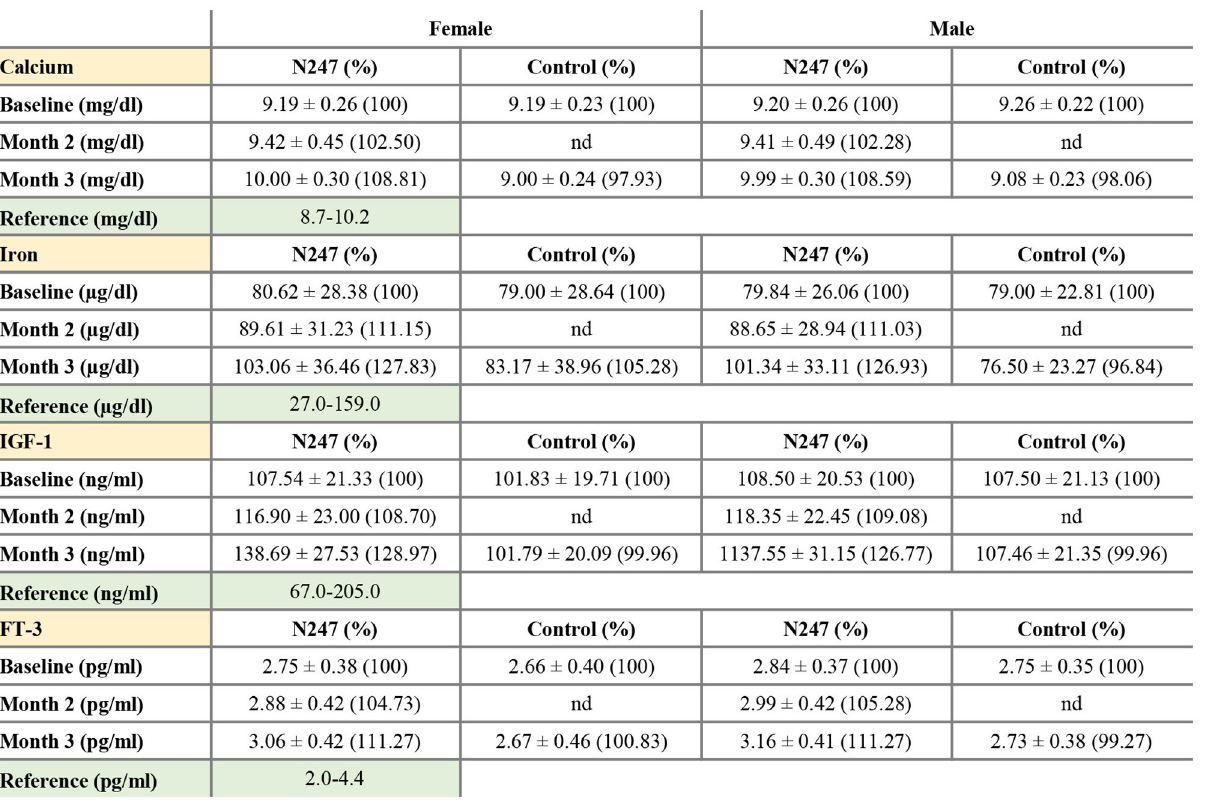
FIGURE 7 | Serum concentrations of calcium, iron, IGF-1, and FT-3. Values are mean